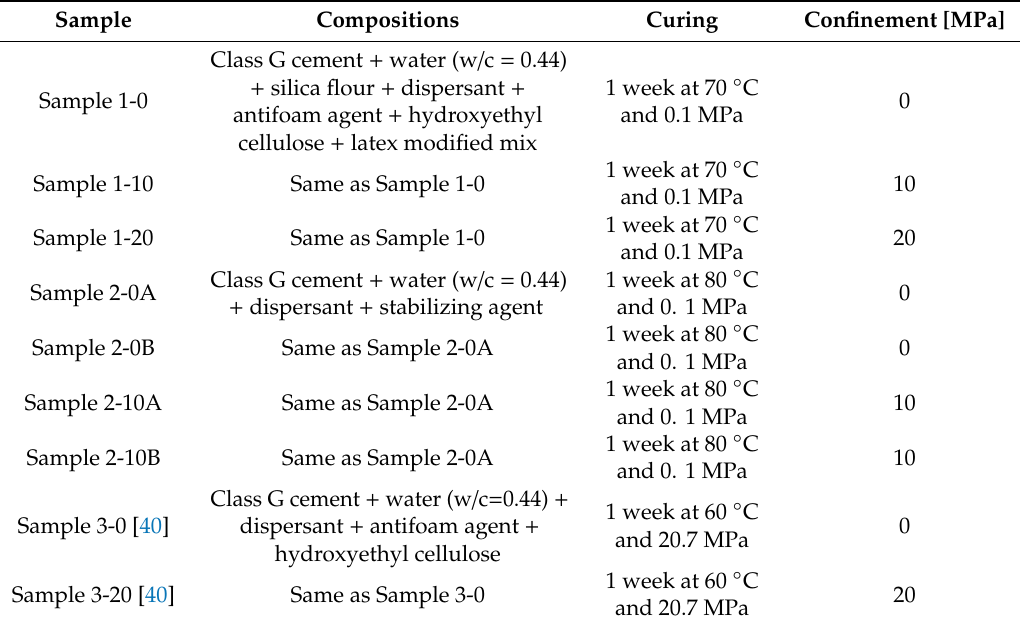
Table 1. Compositions of all materials in the slurry